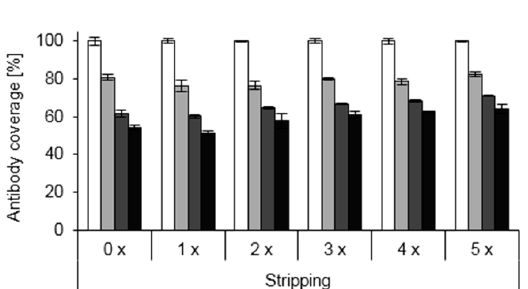
Figure 5. Reusability of functionalized surfaces. Polystyrene surfaces were functionalized with hydrophobins (1.6% EAS- α ) and used for competitive ELISA measurements. After measuring the absorbance values, antibodies were stripped off (see Materials and Methods) and functionalized surfaces were utilized for further measurements the next day.